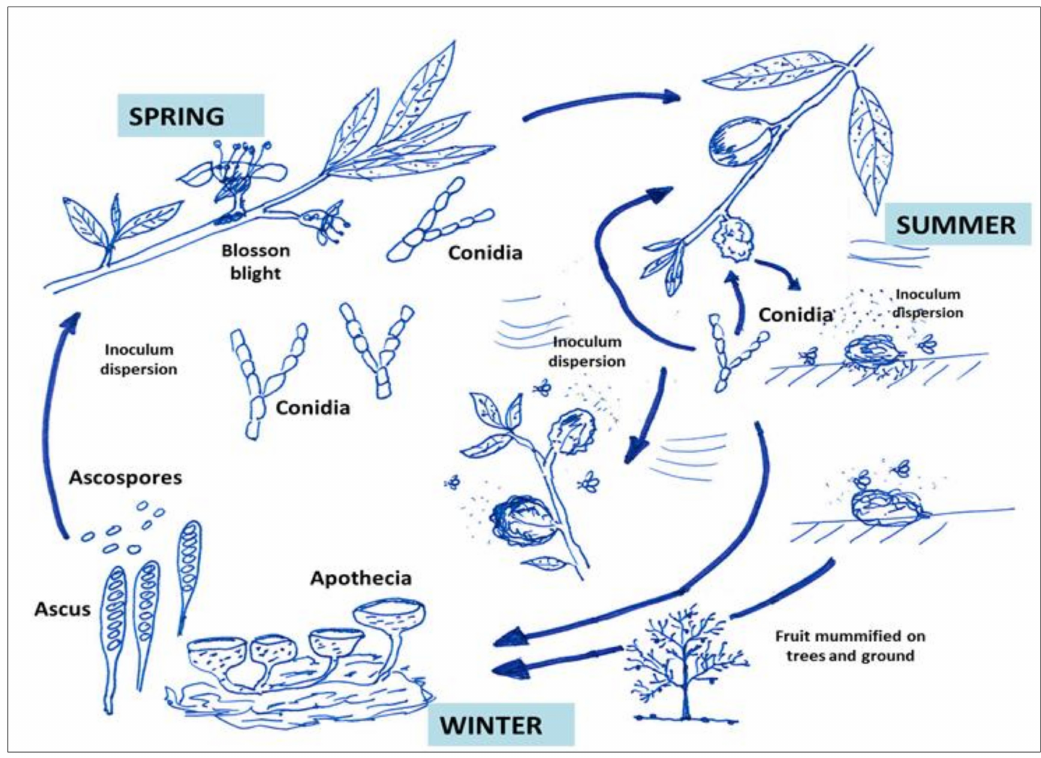
Figure 5. Brown rot disease